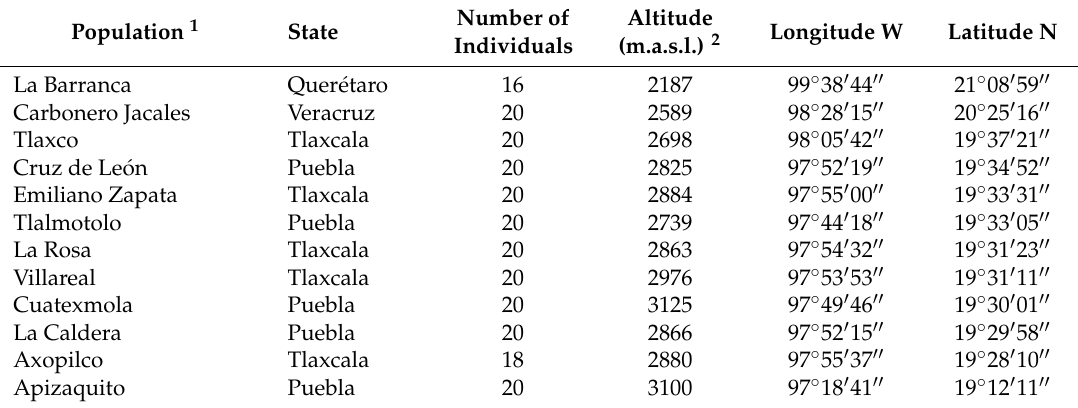
Table 1. Geographic data of the locations of the Pseudotsuga menziesii populations analyzed in this study.